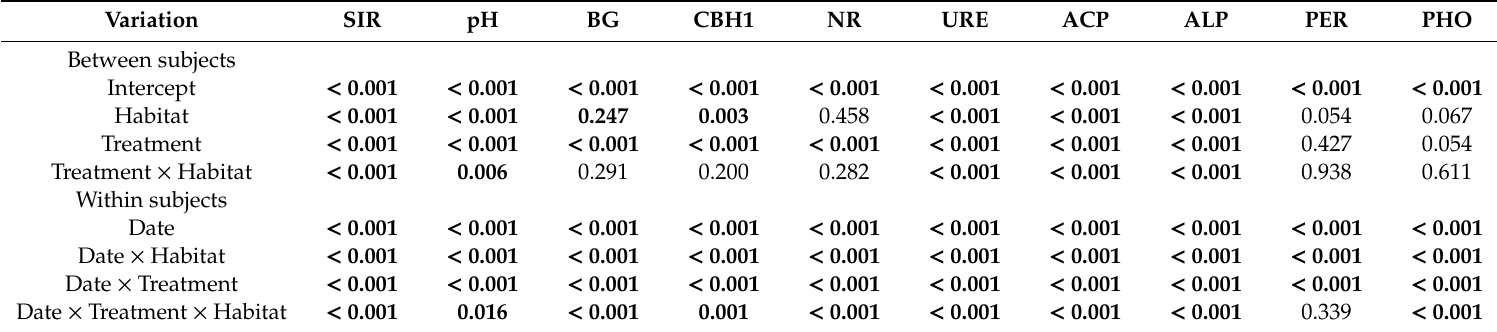
Table 4. E ff ects (indicated by p -values from repeated-measures ANOVA) of sampling date, habitat (oak forest and pine forest), treatment (control, low